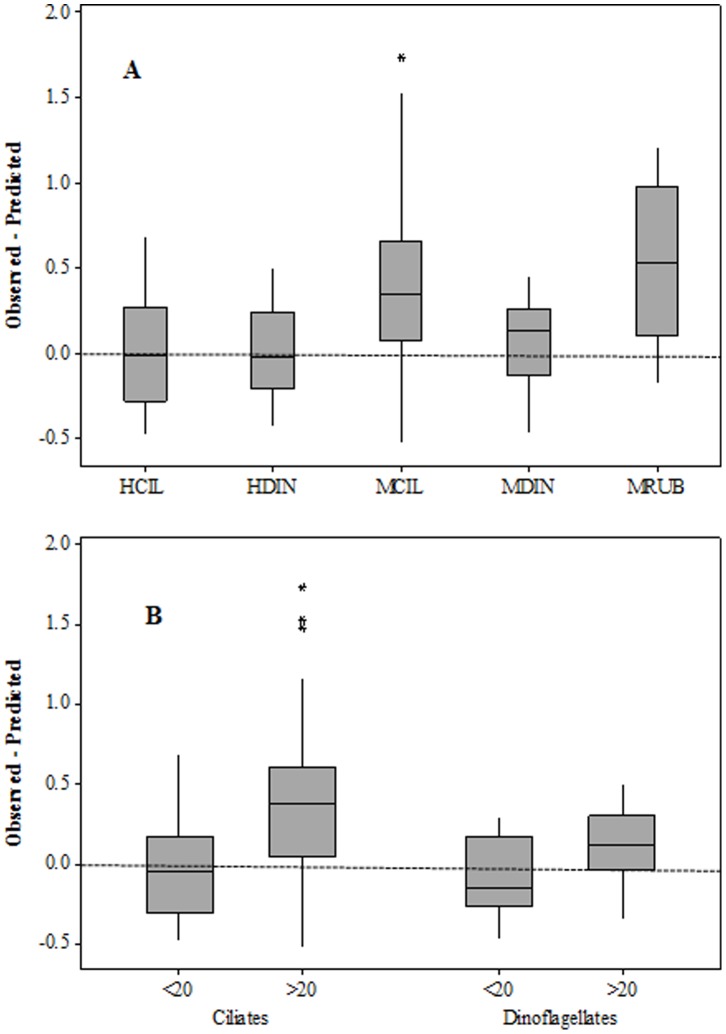
Average differences between observed species-specific and predicted growth rates from Figure 5 separated into microzooplankton functional-taxonomic groups (A) and size-taxonomic groups (B).HCIL = heterotrophic ciliates, HDIN = heterotrophic dinoflagellates, MCIL = mixotrophic ciliates, MDIN = mixotrophic ciliates, MRUB = Mesodinium rubrum.